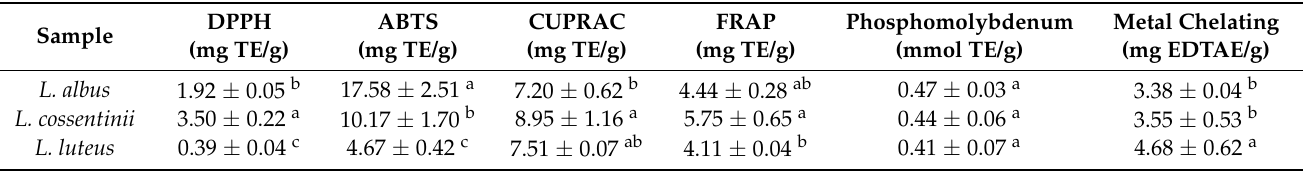
Table 2. In vitro antioxidant capacity in seeds of three Tunisian lupin